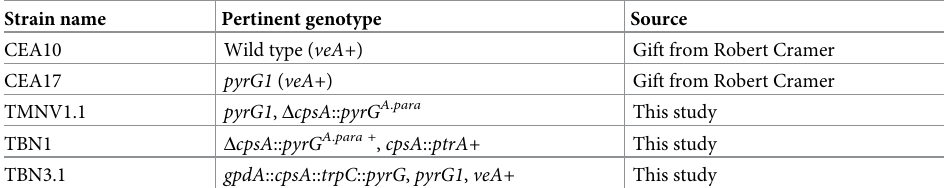
Table 1. Fungal strains used in this study.